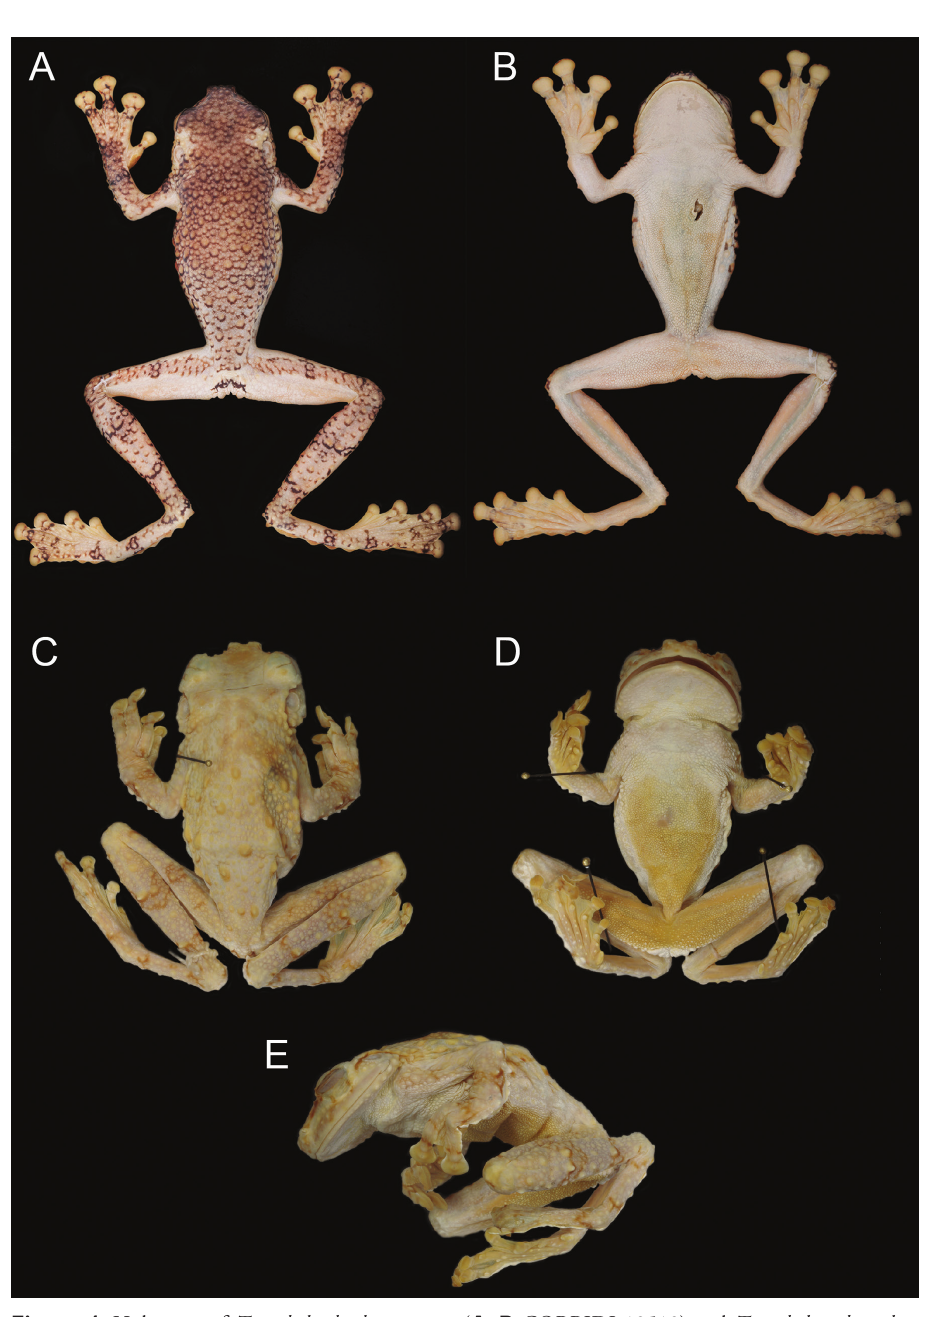
Figure 4. Holotypes of Tepuihyla shushupe sp. n. ( A–B CORBIDI 12513) and Tepuihyla tuberculosa comb. n. ( C–E BMNH 1947.2.13.34). Photos of Tepuihyla tuberculosa comb. n. by M. R.